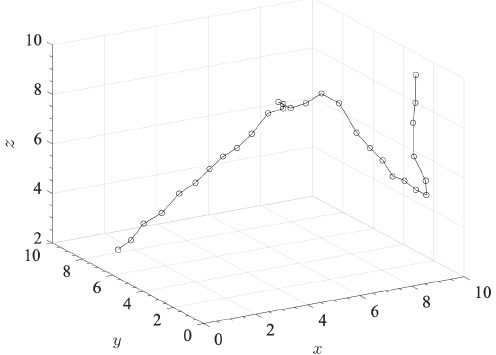
Figure 6. User path within the monitoring space S